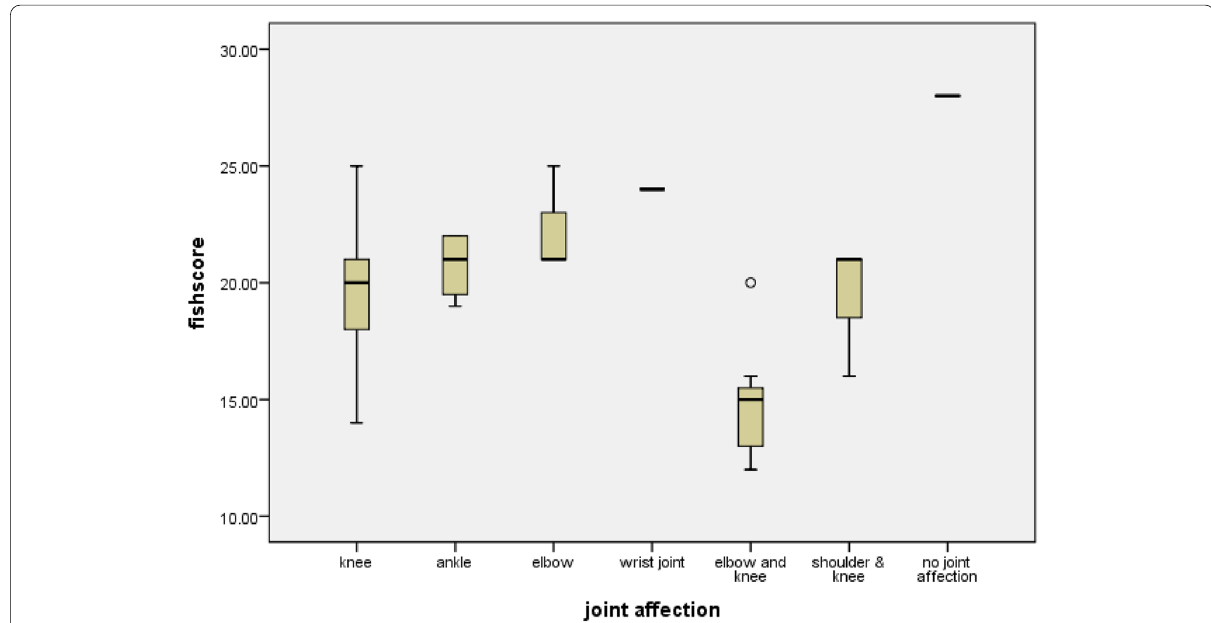
Fig. 6 FISH score according to joint